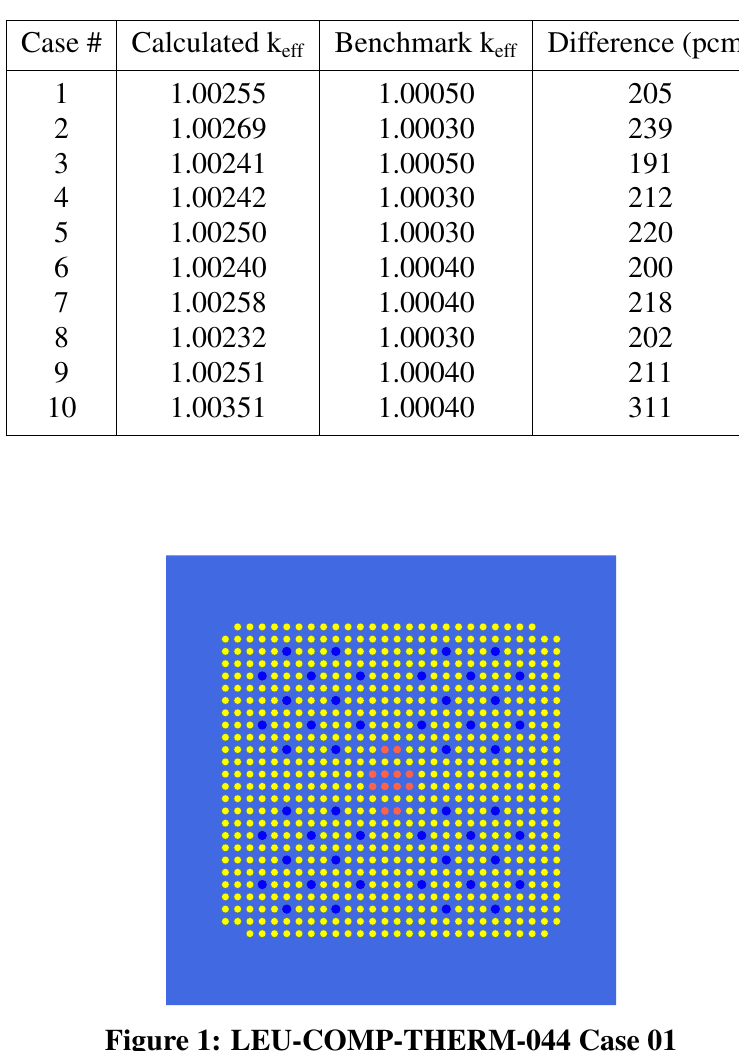
Table 2: LEU-COMP-THERM-044 Results